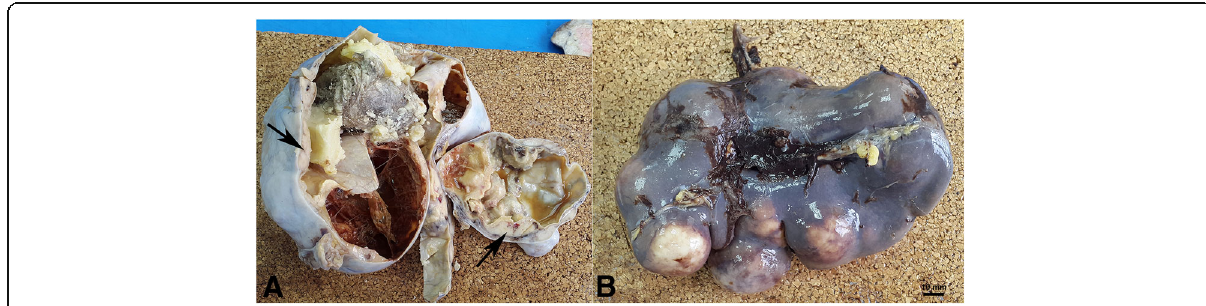
Fig. 1 Macroscopic image of multiloculated ovarian cyst and spleen. a The right ovary was replaced by a cystic tumor (mature teratoma) with multiple solid nodules of PBL within the cyst ’ s walls (arrows). b Spleen with multiple PBL